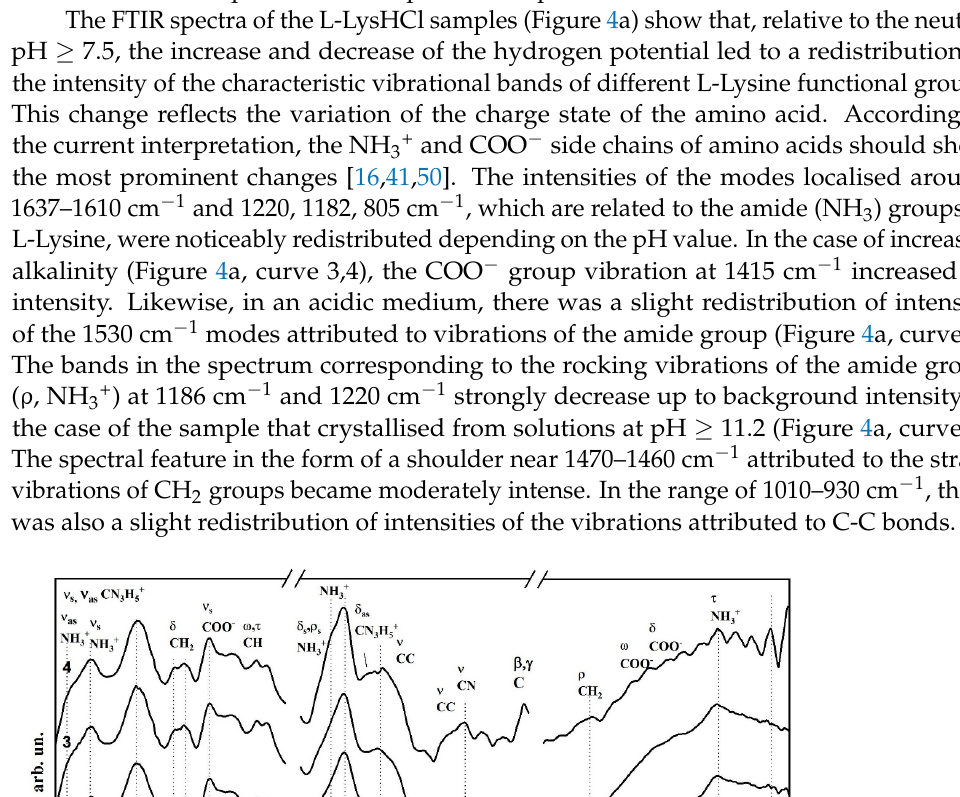
Figure 4. FTIR absorption spectra of the amino acid samples: ( a ) L-LysHCl in the original crystalline state (curve 1) and crystallised from solutions at pH ≤ 5 (curve 2), pH ≥ 7.5 (curve 3) and pH ≥ 11.2 (curve 4); ( b ) L-ArgHCl in the original crystalline state (curve 1) and crystallised from solutions at pH ≤ 5 (curve 2), pH ≥ 7.5 (curve 3) and pH ≥ 11.2 (curve 4).